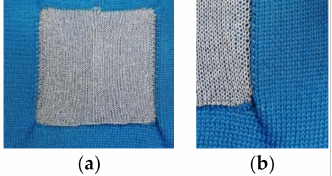
Figure 11. ( a , b ) Rolling in of side edges for the square shaped electrode version E2 on the face